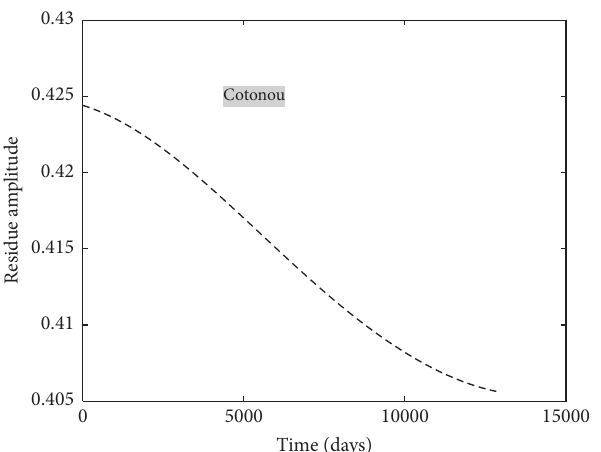
Figure 4: Residues (trend curve) of Cotonou synoptic station based on EEMD in 1951–2010.